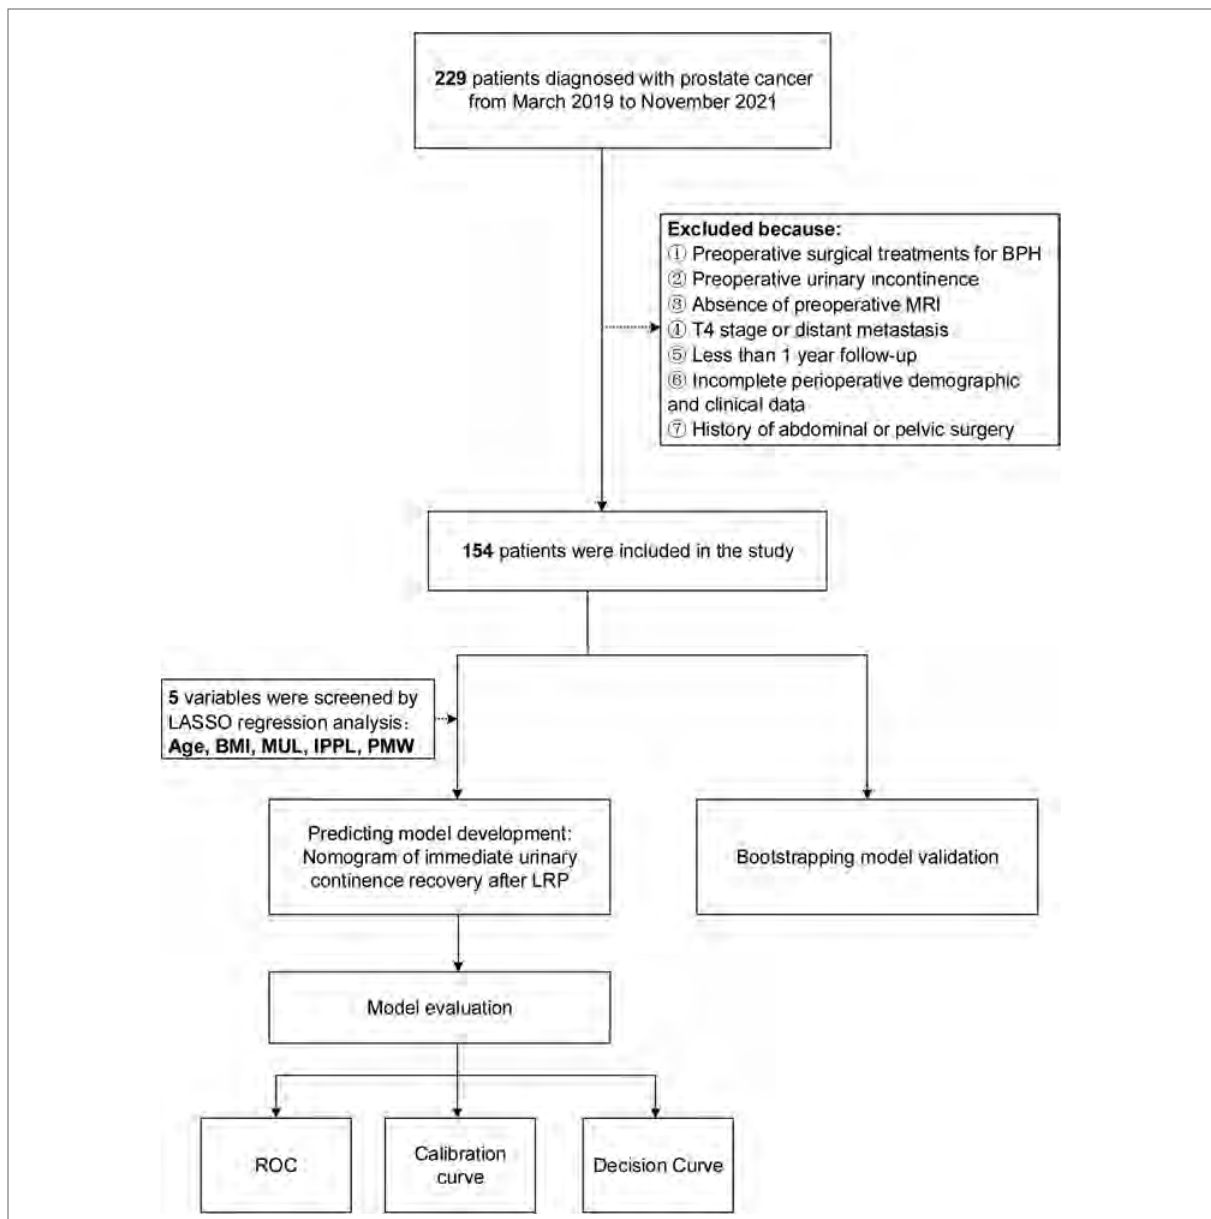
FIGURE 1 Work fl owchart of the patients excluded from the study and the development of predicting model. BMI, body mass index; IPPL, Intravesical prostatic protrusion length; MUL, membranous urethral length; PMW, Puborectalis muscle